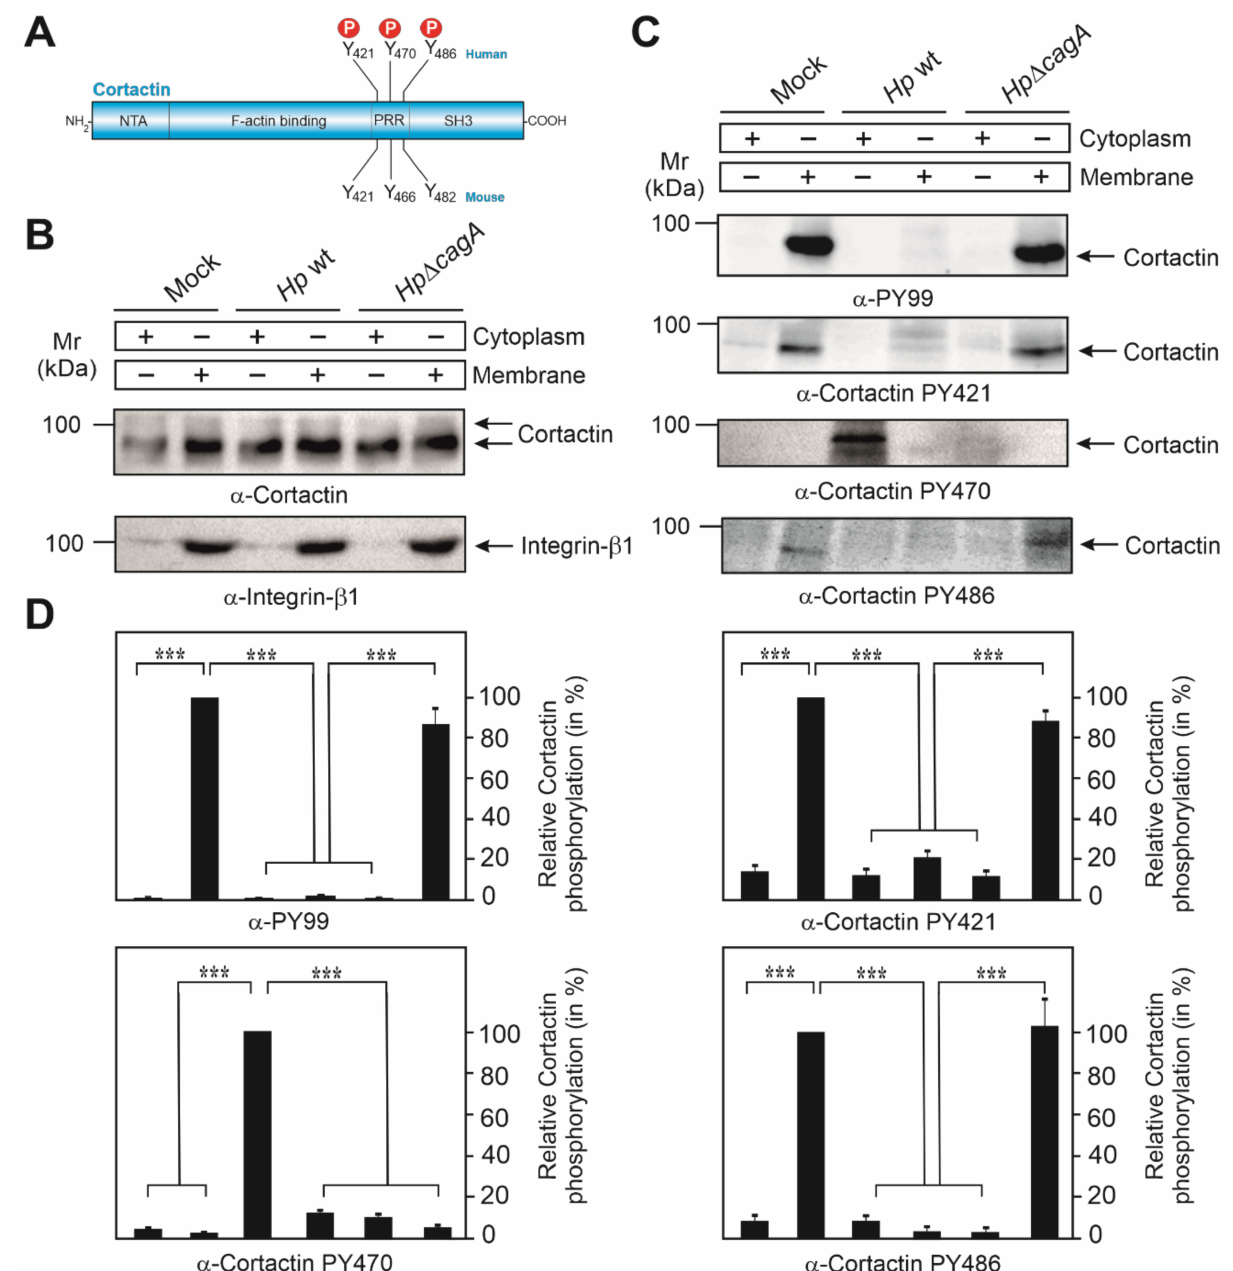
Figure 1. Cortactin undergoes dephosphorylation at tyrosine residues Y-421 and Y-486, and phosphorylation at Y-470 during H. pylori infection. ( A ) Schematic representation of the cortactin domain structure. Three tyrosine phosphorylation sites in human cortactin are shown on top, their mouse counterparts on the bottom. ( B ) AGS cells were co-incubated with wt H. pylori or ∆ cagA mutant for 6 h. Mock control and infected cells were harvested and separated into cytoplasmic and membrane fractions. The loading control blots for cortactin and integrin- β 1 are shown. ( C ) Phosphorylation of cortactin at tyrosine residues 421, 470 and 486 was investigated with the indicated phosphotyrosine-specific antibodies. ( D ) Densitometric quantification of cortactin tyrosine phosphorylation bands of Western blots in panel C. Error bars represent +/ − standard deviation (SD). The results are from three independent experiments. p -values of ≤ 0.001 (***) were considered as statistically